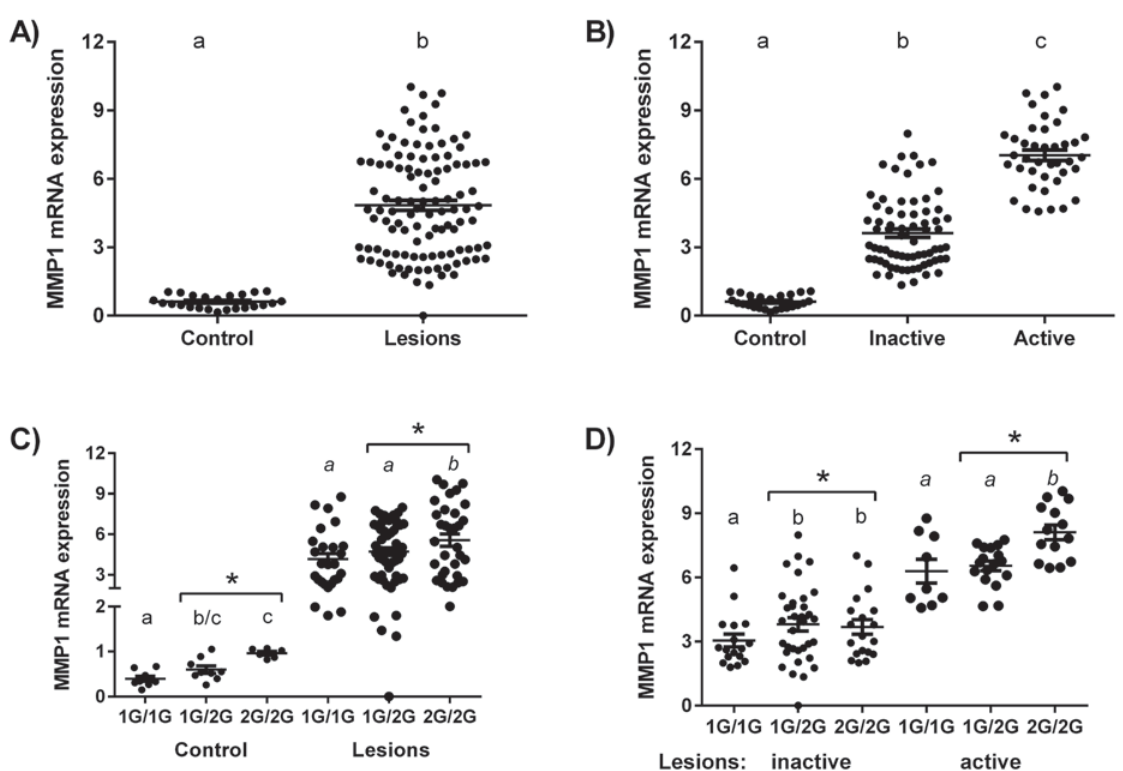
Figure 1- MMP1-1607 SNP and its association with MMP-1 mRNA levels in periapical tissues. Total RNA was extracted from healthy periodontal ligament (control, N=26) and periapical granulomas (lesions, N=111) and levels of MMP-1 mRNA were measured quantitatively by RealTimePCR using TaqMan chemistry; the results are presented as expression of the individual mRNAs (with normalization to beta-actin using the Ct method). A) MMP-1 expression in healthy periapical tissues and periapical lesions; B) MMP-1 expression in healthy periapical tissues and periapical lesions categorized into (cid:68)(cid:70)(cid:87)(cid:76)(cid:89)(cid:72)(cid:3)(cid:82)(cid:85)(cid:3)(cid:76)(cid:81)(cid:68)(cid:70)(cid:87)(cid:76)(cid:89)(cid:72)(cid:3)(cid:69)(cid:68)(cid:86)(cid:72)(cid:71)(cid:3)(cid:82)(cid:81)(cid:3)(cid:87)(cid:75)(cid:72)(cid:3)(cid:83)(cid:85)(cid:82)(cid:191)(cid:79)(cid:72)(cid:3)(cid:82)(cid:73)(cid:3)(cid:53)(cid:36)(cid:49)(cid:46)(cid:47)(cid:18)(cid:50)(cid:51)(cid:42)(cid:3)(cid:72)(cid:91)(cid:83)(cid:85)(cid:72)(cid:86)(cid:86)(cid:76)(cid:82)(cid:81)(cid:30)(cid:3)(cid:38)(cid:12)(cid:3)(cid:48)(cid:48)(cid:51)(cid:16)(cid:20)(cid:3)(cid:72)(cid:91)(cid:83)(cid:85)(cid:72)(cid:86)(cid:86)(cid:76)(cid:82)(cid:81)(cid:3)(cid:76)(cid:81)(cid:3)(cid:75)(cid:72)(cid:68)(cid:79)(cid:87)(cid:75)(cid:92)(cid:3)(cid:83)(cid:72)(cid:85)(cid:76)(cid:82)(cid:71)(cid:82)(cid:81)(cid:87)(cid:68)(cid:79)(cid:3)(cid:79)(cid:76)(cid:74)(cid:68)(cid:80)(cid:72)(cid:81)(cid:87)(cid:3) and periapical lesions patients according to their genotype for MMP1-1607, determined by RealTimePCR using Taqman (cid:70)(cid:75)(cid:72)(cid:80)(cid:76)(cid:86)(cid:87)(cid:85)(cid:92)(cid:30)(cid:3)(cid:39)(cid:12)(cid:3)(cid:48)(cid:48)(cid:51)(cid:16)(cid:20)(cid:3)(cid:72)(cid:91)(cid:83)(cid:85)(cid:72)(cid:86)(cid:86)(cid:76)(cid:82)(cid:81)(cid:3)(cid:76)(cid:81)(cid:3)(cid:83)(cid:72)(cid:85)(cid:76)(cid:68)(cid:83)(cid:76)(cid:70)(cid:68)(cid:79)(cid:3)(cid:79)(cid:72)(cid:86)(cid:76)(cid:82)(cid:81)(cid:86)(cid:3)(cid:70)(cid:68)(cid:87)(cid:72)(cid:74)(cid:82)(cid:85)(cid:76)(cid:93)(cid:72)(cid:71)(cid:3)(cid:76)(cid:81)(cid:87)(cid:82)(cid:3)(cid:68)(cid:70)(cid:87)(cid:76)(cid:89)(cid:72)(cid:3)(cid:82)(cid:85)(cid:3)(cid:76)(cid:81)(cid:68)(cid:70)(cid:87)(cid:76)(cid:89)(cid:72)(cid:3)(cid:69)(cid:68)(cid:86)(cid:72)(cid:71)(cid:3)(cid:82)(cid:81)(cid:3)(cid:87)(cid:75)(cid:72)(cid:3)(cid:83)(cid:85)(cid:82)(cid:191)(cid:79)(cid:72)(cid:3)(cid:82)(cid:73)(cid:3)(cid:53)(cid:36)(cid:49)(cid:46)(cid:47)(cid:18) OPG expression according to patients genotype for MMP1-1607, determined by RealTimePCR using Taqman chemistry. (cid:39)(cid:76)(cid:73)(cid:73)(cid:72)(cid:85)(cid:72)(cid:81)(cid:87)(cid:3)(cid:79)(cid:72)(cid:87)(cid:87)(cid:72)(cid:85)(cid:86)(cid:3)(cid:11)(cid:68)(cid:15)(cid:3)(cid:69)(cid:15)(cid:3)(cid:70)(cid:12)(cid:3)(cid:85)(cid:72)(cid:83)(cid:85)(cid:72)(cid:86)(cid:72)(cid:81)(cid:87)(cid:3)(cid:86)(cid:87)(cid:68)(cid:87)(cid:76)(cid:86)(cid:87)(cid:76)(cid:70)(cid:68)(cid:79)(cid:79)(cid:92)(cid:3)(cid:86)(cid:76)(cid:74)(cid:81)(cid:76)(cid:191)(cid:70)(cid:68)(cid:81)(cid:87)(cid:3)(cid:71)(cid:76)(cid:73)(cid:73)(cid:72)(cid:85)(cid:72)(cid:81)(cid:70)(cid:72)(cid:86)(cid:3)(cid:90)(cid:76)(cid:87)(cid:75)(cid:76)(cid:81)(cid:3)(cid:87)(cid:75)(cid:72)(cid:3)(cid:74)(cid:85)(cid:82)(cid:88)(cid:83)(cid:86)(cid:3)(cid:11)(cid:83)(cid:31)(cid:19)(cid:17)(cid:19)(cid:24)(cid:30)(cid:3)(cid:88)(cid:81)(cid:83)(cid:68)(cid:76)(cid:85)(cid:72)(cid:71)(cid:3)(cid:87)(cid:16)(cid:87)(cid:72)(cid:86)(cid:87)(cid:3)(cid:82)(cid:85)(cid:3)(cid:50)(cid:81)(cid:72)(cid:16)(cid:90)(cid:68)(cid:92)(cid:3) (cid:36)(cid:49)(cid:50)(cid:57)(cid:36)(cid:15)(cid:3)(cid:37)(cid:82)(cid:81)(cid:73)(cid:72)(cid:85)(cid:85)(cid:82)(cid:81)(cid:76)(cid:3)(cid:83)(cid:82)(cid:86)(cid:87)(cid:16)(cid:87)(cid:72)(cid:86)(cid:87)(cid:12)(cid:30)(cid:3)(cid:13)(cid:3)(cid:85)(cid:72)(cid:83)(cid:85)(cid:72)(cid:86)(cid:72)(cid:81)(cid:87)(cid:86)(cid:3)(cid:86)(cid:87)(cid:68)(cid:87)(cid:76)(cid:86)(cid:87)(cid:76)(cid:70)(cid:68)(cid:79)(cid:79)(cid:92)(cid:3)(cid:86)(cid:76)(cid:74)(cid:81)(cid:76)(cid:191)(cid:70)(cid:68)(cid:81)(cid:87)(cid:3)(cid:71)(cid:76)(cid:73)(cid:73)(cid:72)(cid:85)(cid:72)(cid:81)(cid:70)(cid:72)(cid:86)(cid:3)(cid:69)(cid:72)(cid:87)(cid:90)(cid:72)(cid:72)(cid:81)(cid:3)(cid:20)(cid:42)(cid:18)(cid:20)(cid:42)(cid:3)(cid:68)(cid:81)(cid:71)(cid:3)(cid:20)(cid:42)(cid:18)(cid:21)(cid:42)(cid:14)(cid:21)(cid:42)(cid:18)(cid:21)(cid:42)(cid:3)(cid:74)(cid:85)(cid:82)(cid:88)(cid:83)(cid:86)(cid:3)